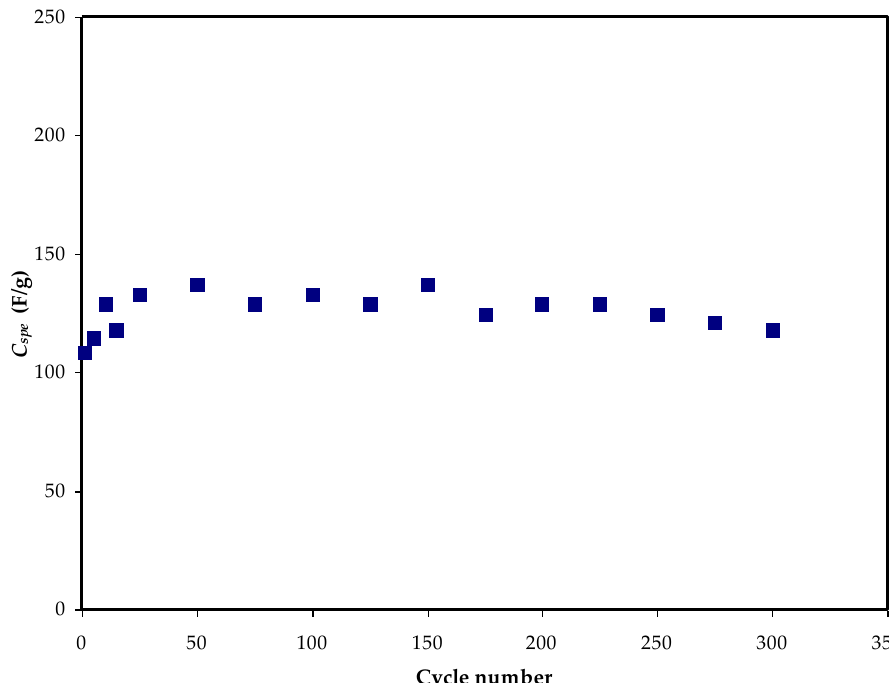
Figure 5. The GCD performances of the fabricated EDLC.